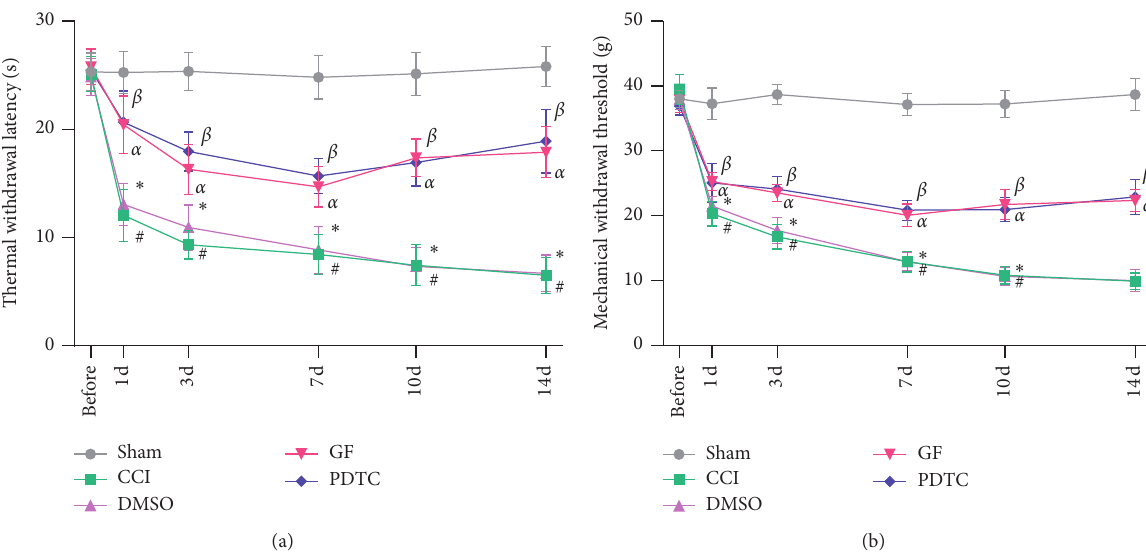
Figure 1: The thermal withdrawal latency and mechanical paw withdrawal threshold in chronic constriction injury (CCI) rats significantly decreased in the CCI group and DMSO group compared with the Sham group after CCI surgery. Inhibiting PKC and NF- κ B increased the thermal withdrawal latency and mechanical paw withdrawal threshold in CCI rats. Data are expressed as mean ± SD ( n � 16 for each group). Statistical analysis was conducted by the one-way ANOVA tests and the S-N-Q test. # P < 0 . 05, ∗ P < 0 . 05 vs. Sham group, α P < 0 . 05, β P < 0 . 05 vs. CCI group. α P < 0 . 05 vs. CCI +GF109203X